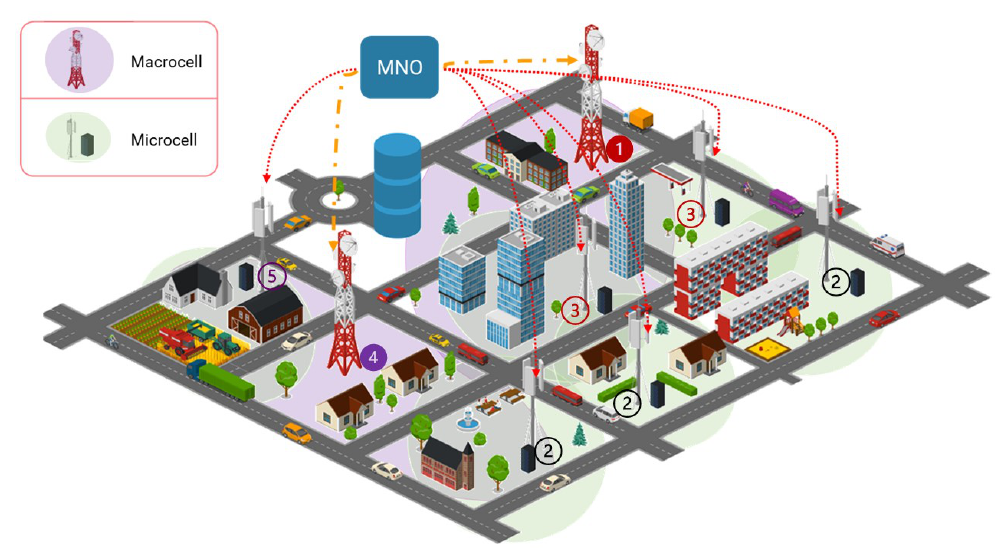
Figure 1. Mobile network operators (MNO) builds the composite indicator from KPIs of 5 different clusters of cells: urban macro (1), suburban (2), urban micro (3), rural macro (4), and rural micro